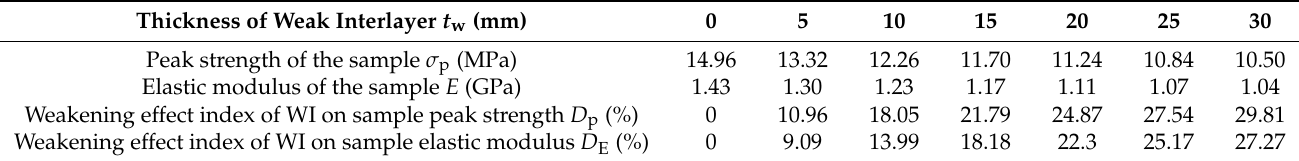
Table 4. The σ p , E , D p , and D E for weak interlayer with different thicknesses. Thickness of Weak Interlayer t w (mm) Elastic modulus of the sample E